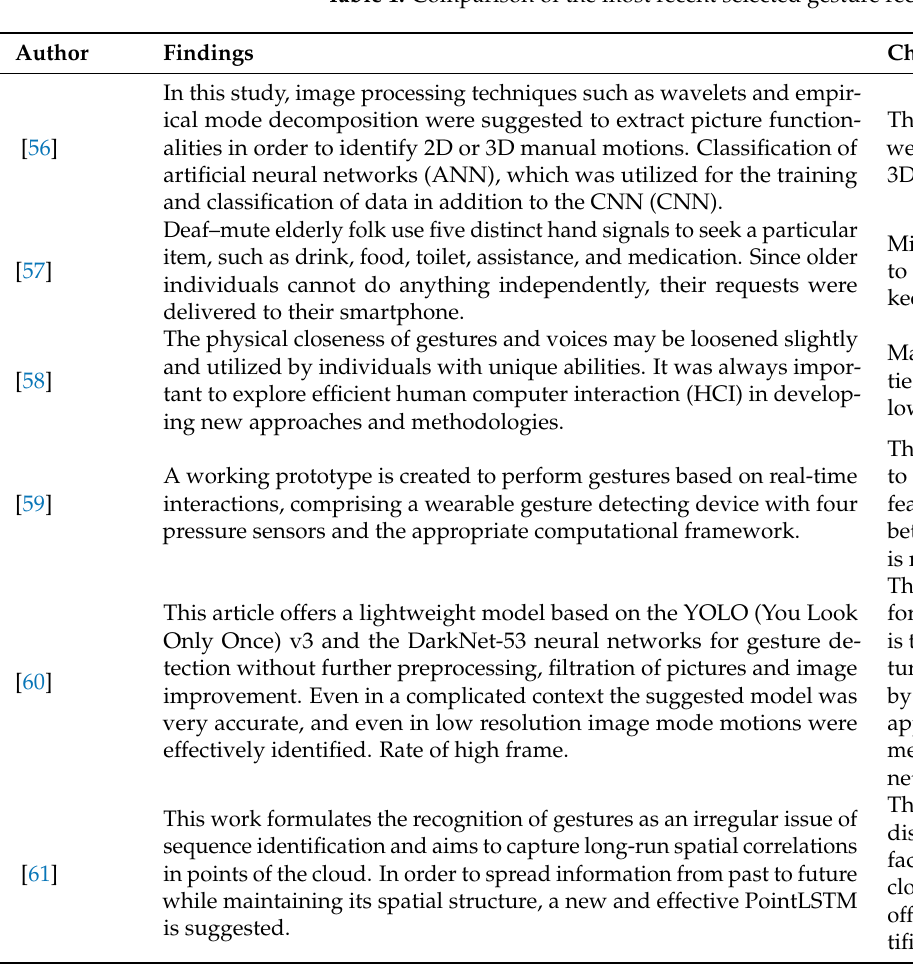
Table 1. Comparison of the most recent selected gesture recognition